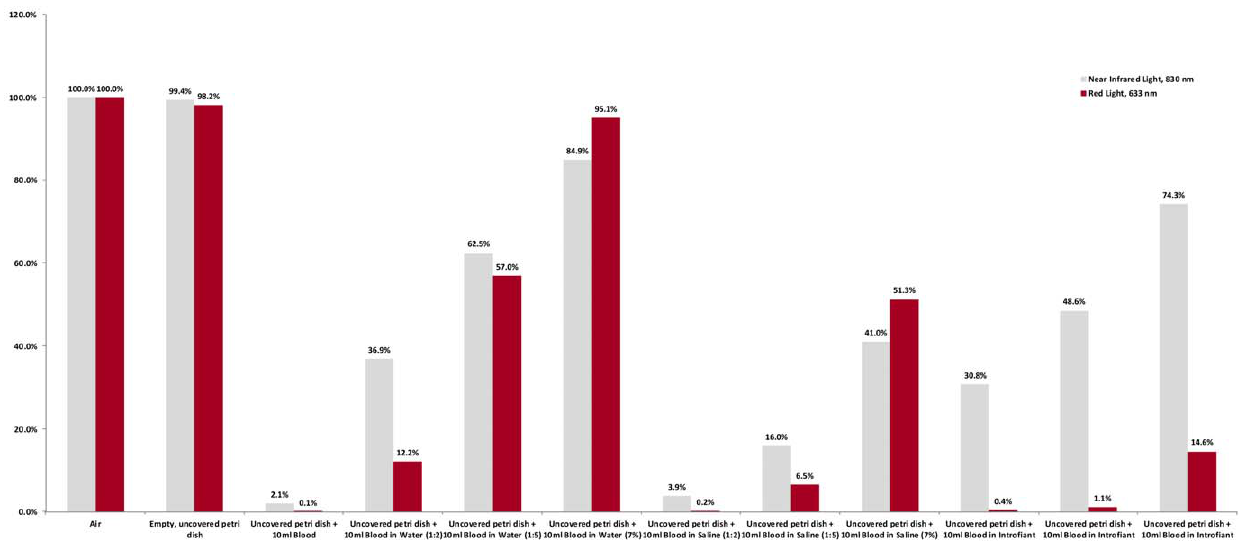
Figure 4. Percent Penetrance of Light through Various Concentrations of Blood. Blood attenuates the transmission of both near infrared and red lights. When blood was diluted in normal saline to a concentration of 7%, representing physiologic conditions, transmission of near infrared light was decreased to 41%.